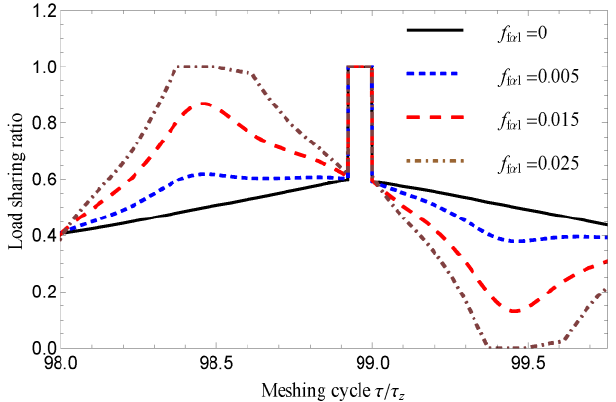
Figure 13. Dynamic mesh force of a single pair of teeth under different 𝑓 𝑓𝛼1 .